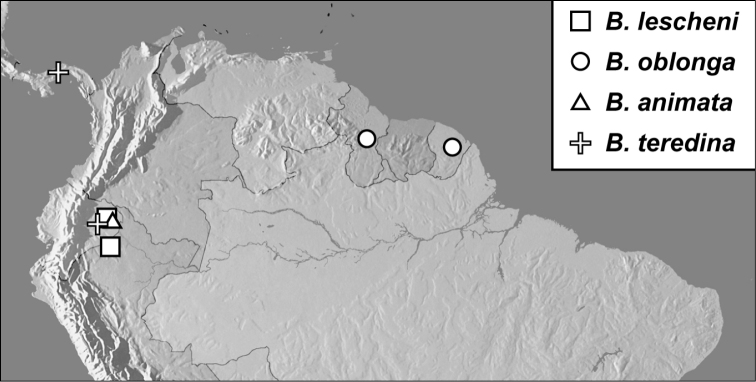
Baconia aeneomicans group records.